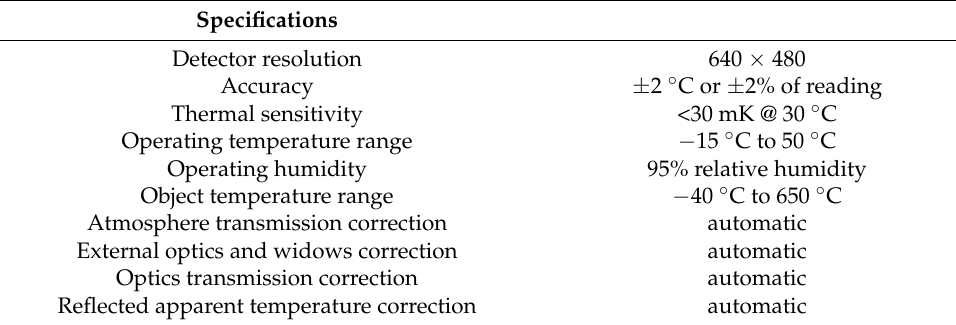
Table 1. Specifications of the FLIR T630 handheld thermal cameras.